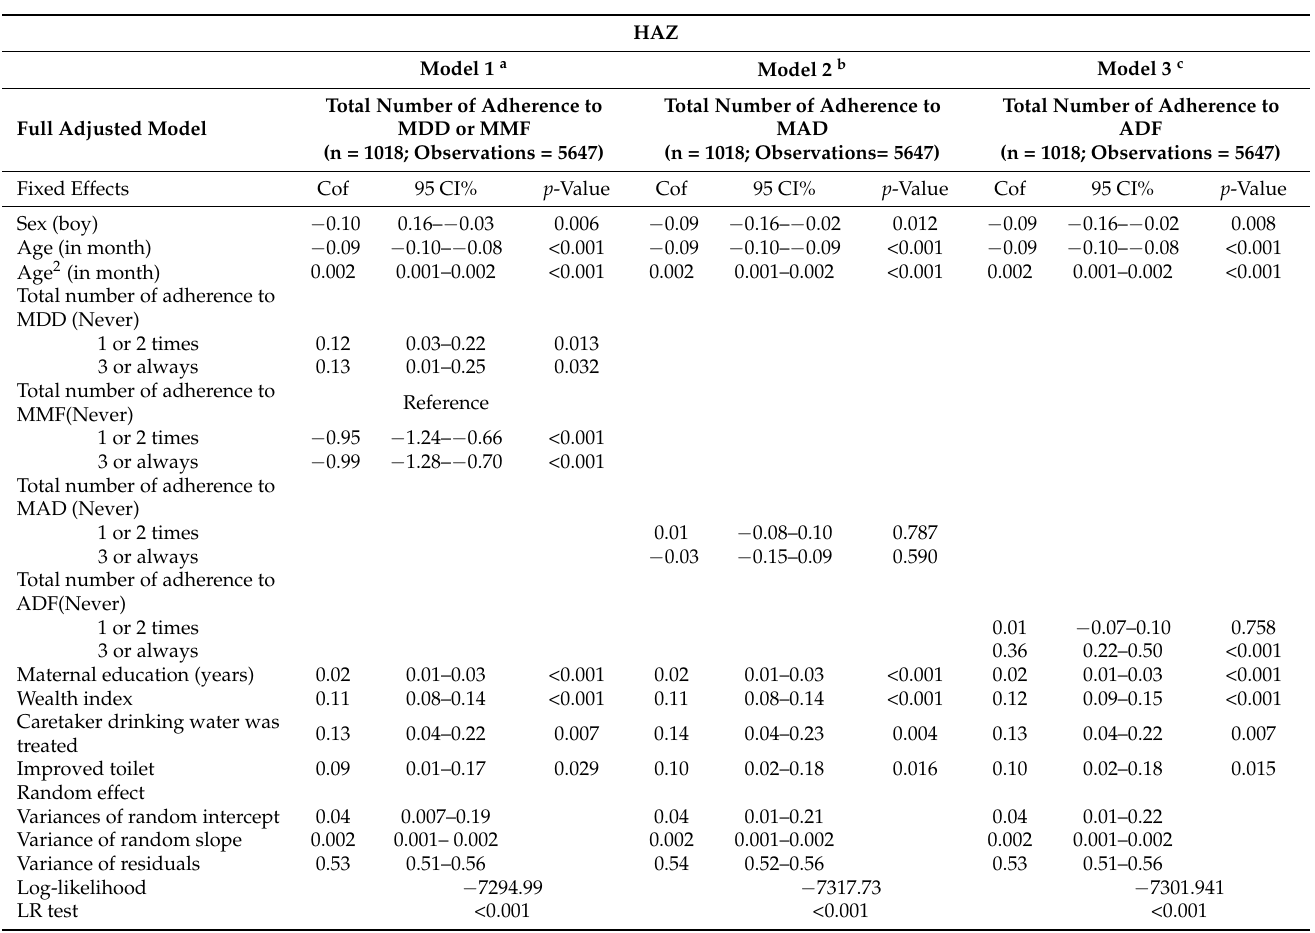
Table 4. The relationship of adherence to age-appropriate feeding practices and other determinants with child height-for-age